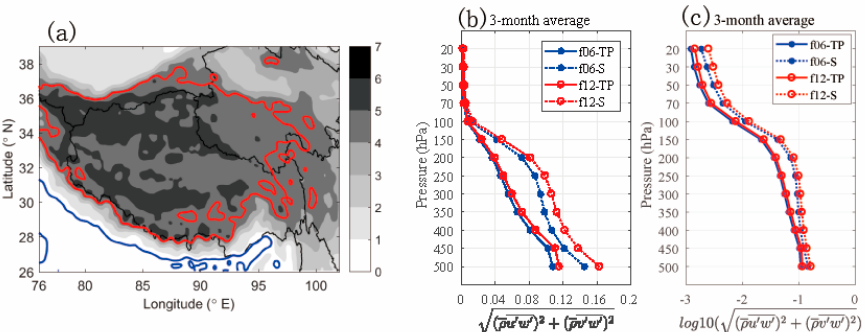
Figure 1. ( a ) Terrain height (unit: km; shading). The thin black lines are the province border. The red line represents the topography height at 4.5 km. The blue line represents the topography height at 0.3 km. ( b ) Area-averaged and 3-month-averaged horizontal momentum fluxes per unit volume (unit: Pa) and ( c ) common logarithm (base 10) of area-averaged and 3-month-averaged horizontal momentum fluxes per unit volume (unit: Pa) over the main TP (solid lines) and the south slope of the TP (dotted lines) from 6-h forecast results (blue lines) and 12-h forecast results (red lines). Legends in ( b , c ) are abbreviations of the simulation information. For example, f06 (12) refers to the 6(12)-h forecast. TP refers to the main TP region and S refers to the south slope of the TP.